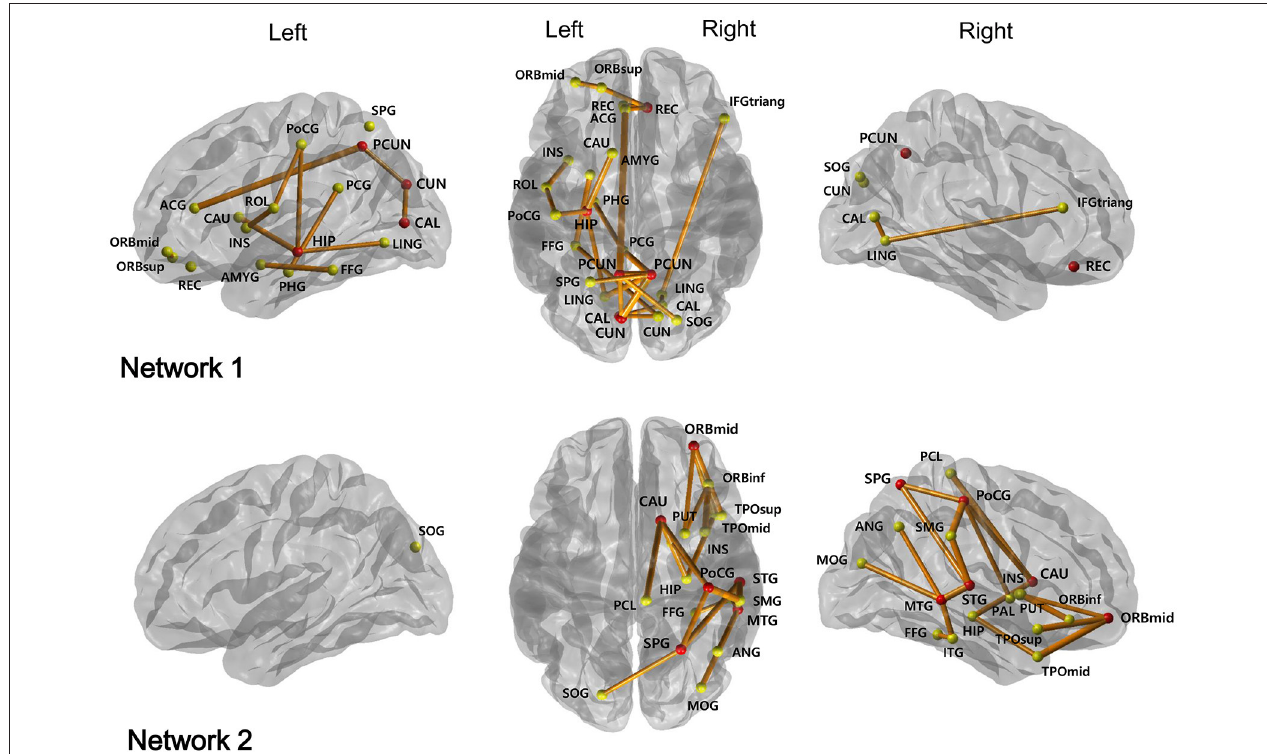
FIGURE 1 | Two subnetworks were identified by network-based statistics, which show the reduced connectivities in NMOSD patients compared to healthy controls. The red circles represent their hub regions representing the brain regions most affected by the white matter disruption, while the other yellow circles are the non-hub brain regions. ORBsup, Superior frontal gyrus, orbital part; ORBmid, Middle frontal gyrus, orbital part; REC, Rectus; ROL, Rolandic operculum; INS, Insula; ACG, Anterior cingulum; PCG, Posterior cingulum; PHG, Parahippocampal gyrus; CAL, Calcarine; CUN, Cuneus; HIP, Hippocampus; LING, Lingual gyrus; IFGtriang, Inferior frontal gyrus, triangular part; AMYG, Amygdala; FFG, Fusiform gyrus; PoCG, Post-central gyrus; SOG, Superior occipital gyrus; PCUN, Precuneus; SPG, Superior parietal gyrus; CAU, Caudate; ORBinf, Inferior frontal gyrus, orbital part; SMG, Supramarginal gyrus; PCL, Paracentral lobule; PUT, Putamen; PAL, Pallidum; STG, Superior temporal gyrus; TPOsup, Temporal pole: middle temporal gyrus; MTG, Middle temporal gyrus; MOG, Middls occipital gyrus; ANG, Angular gyrus; TPOmid, Temporal pole: middle temporal gyrus; ITG, Inferior temporal